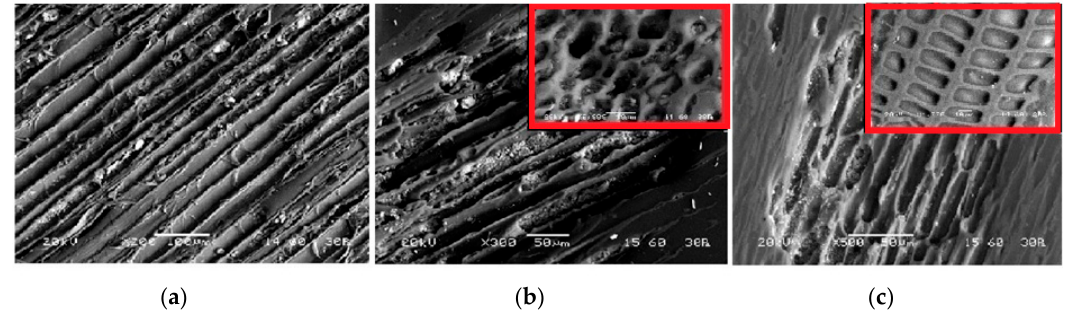
Figure 2. SEM-BSI images of the Sd (×200) ( a ), Sd350 (×300 and ×2000) ( b ) and Sd350 (×500 and ×1000) ( c